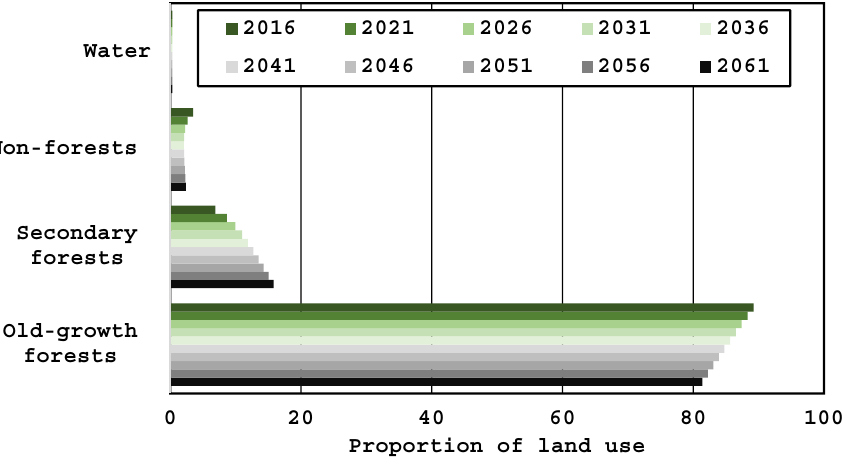
Figure 9. Future evolution of the composition of the occupation according to the scenario of SEM. In the rapid economic growth scenario, the future dynamics of the landscape will come at the expense of forests (Figure 10).